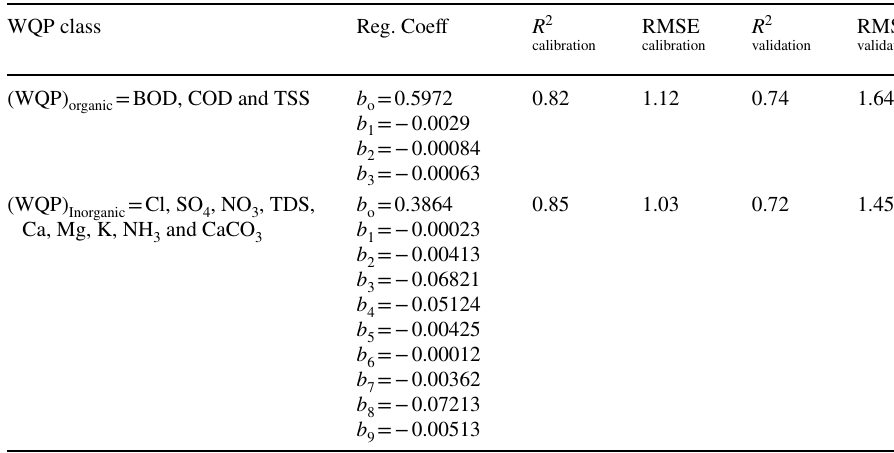
RGB : mean RGB or {( R + G + B )∕ 3 } Table 3 Multiple linear regression coefficients and R 2 values for � ( RGB ) × √ B ∕ R � . Band combination with combined data of all sampling